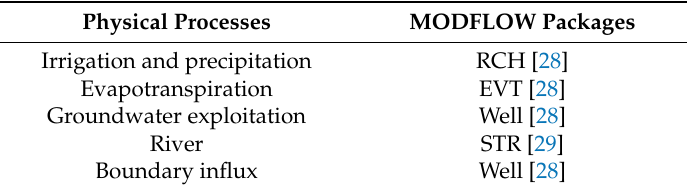
Table 1. Packages used in the establishment of the groundwater model.